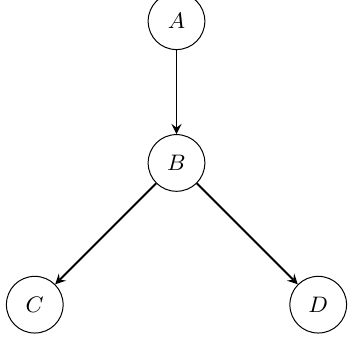
Figure 4: Simple Bayesian